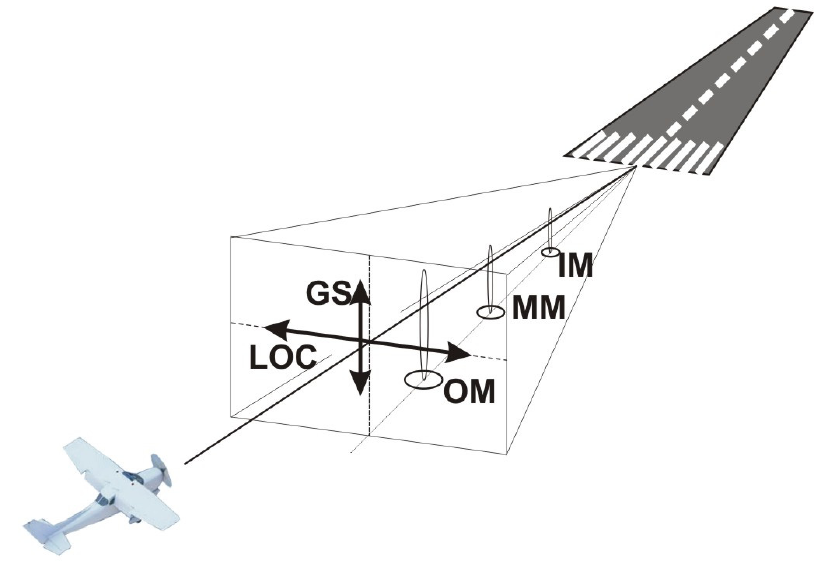
Figure 1. Diagram of radio-navigation on an approach to landing with the use of ILS. GS—Glide Slope, IM—Inner marker, LOC—Localizer, MM—Middle Marker, OM—Outer Marker.